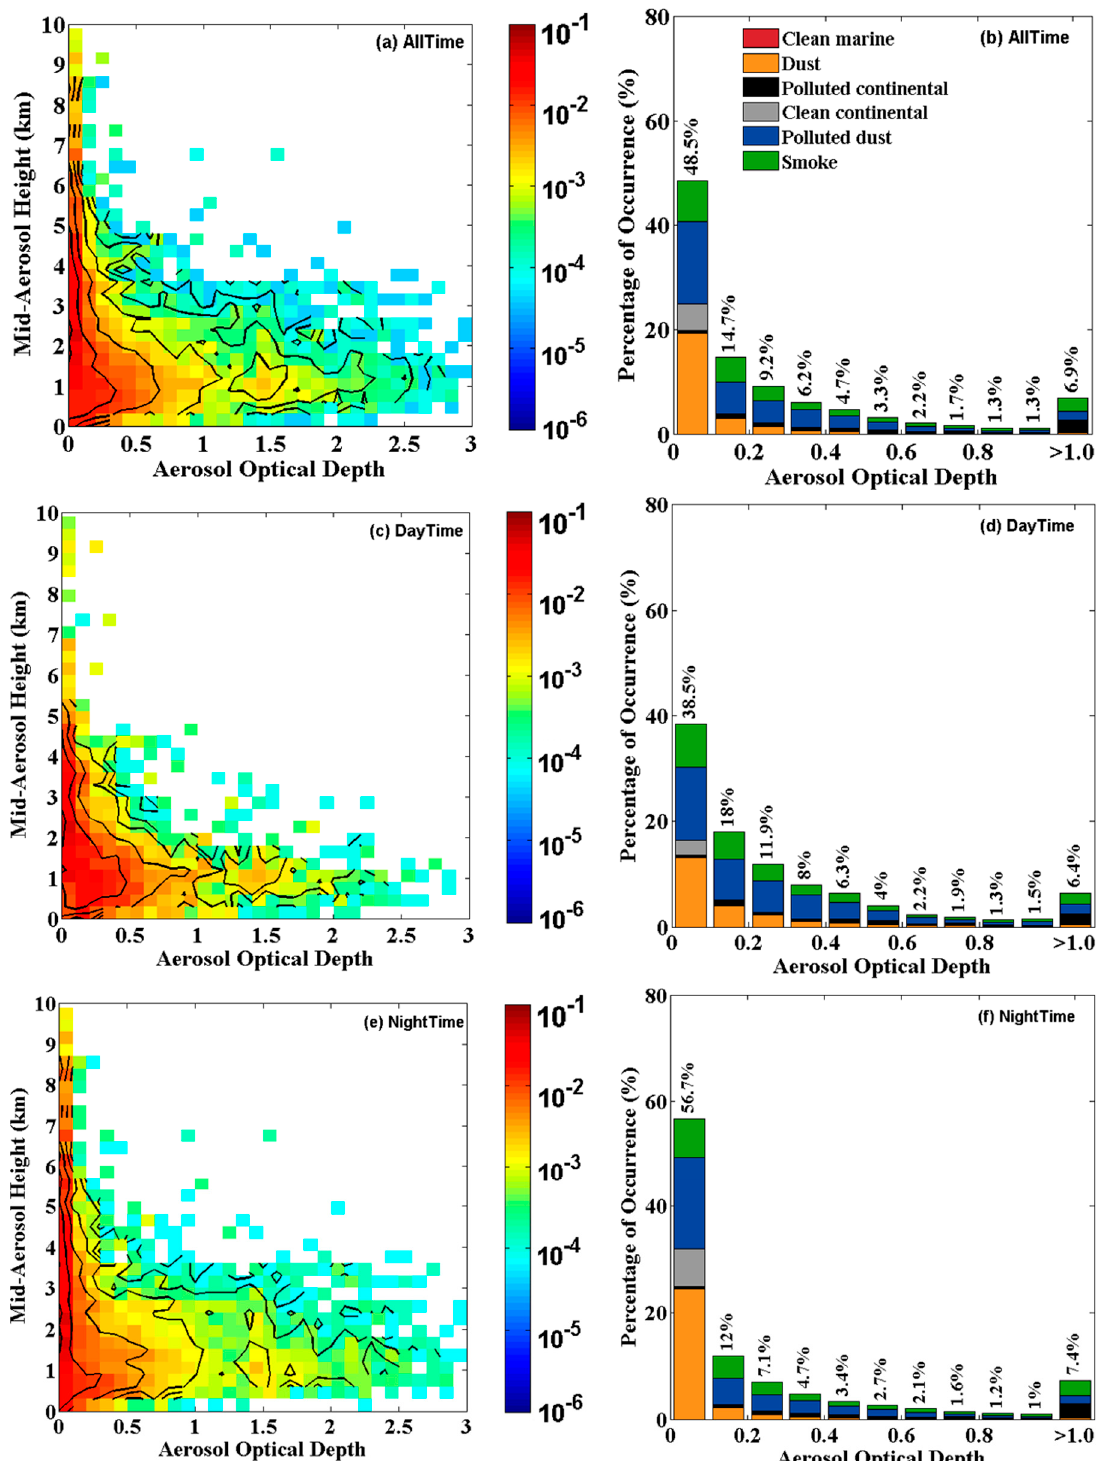
Figure 6. ( a ) Joint probability distribution of aerosol optical depth (AOD) of aerosol layers combined with mid-aerosol height at 0.3 km bin size, and ( b ) the corresponding AOD probability distribution of aerosol layers with each aerosol type during the whole study time over central China from March 2007 to February 2016. ( c , d ) and ( e , f ) are the same as ( a , b ) but for daytime and nighttime, respectively. The black solid line indicates the joint probability contour plots.